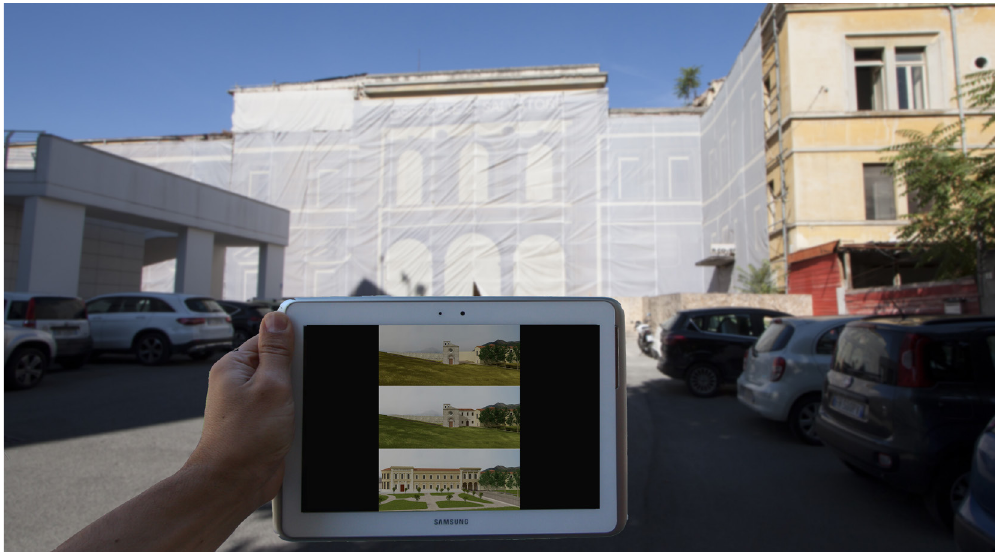
Fig. 6 San Basilio Square in L’Aquila (IT). Visualizing the historical reconstructions in Augmented